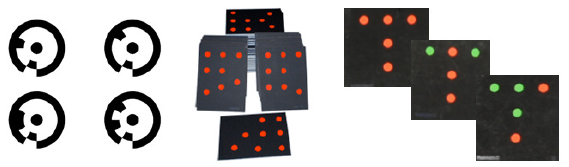
Figure 3. Examples of coded targets.